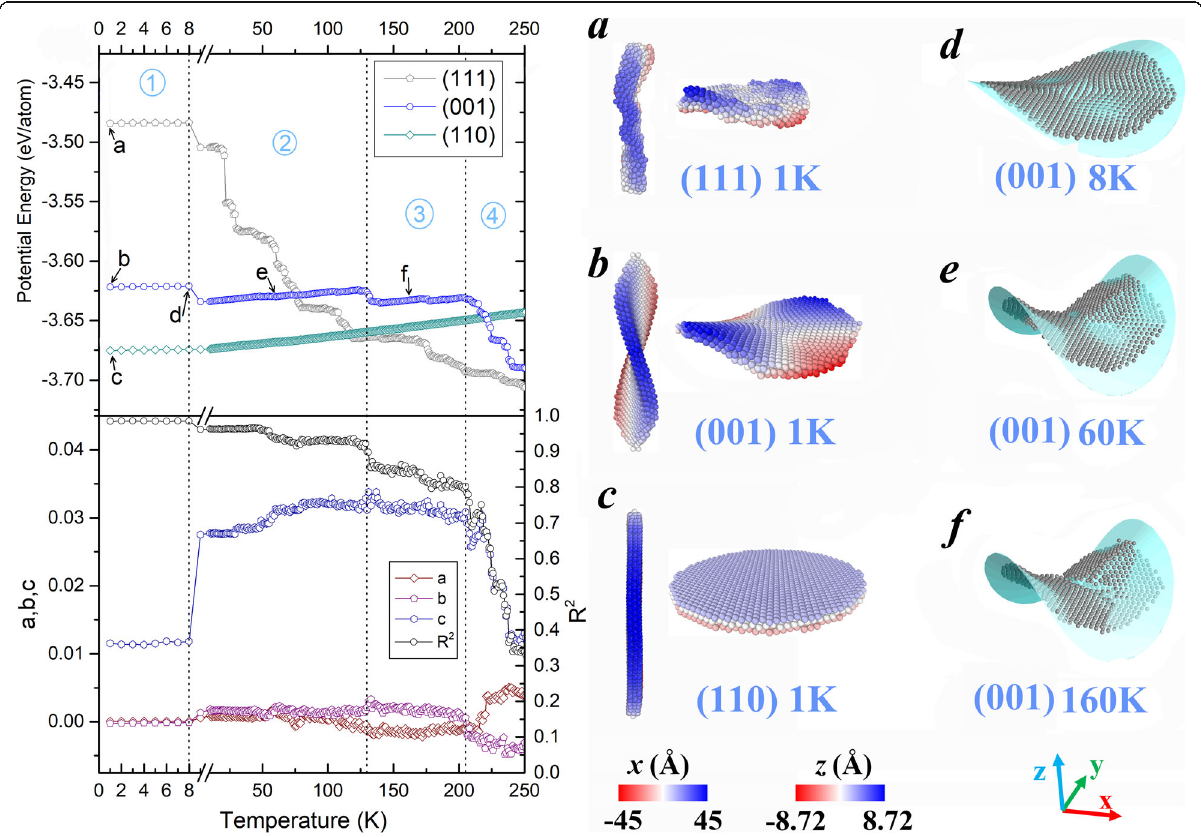
Fig. 1 Left panel: Temperature evolution of the potential energy of three nanoplates (upper plots), and the geometric parameters obtained by fitting the middle layer of the (001) nanoplate (lower plots); Right panel: a , b , c Snapshots of three nanoplates after relaxation. d , e , f Snapshots of the middle layer in the (001) nanoplate taken at representative temperatures. Cyan surfaces denote the corresponding fitting